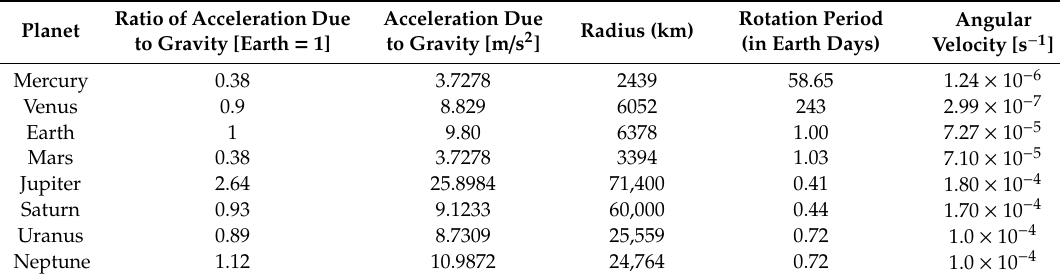
Table 4. Data for the planets in the Solar System